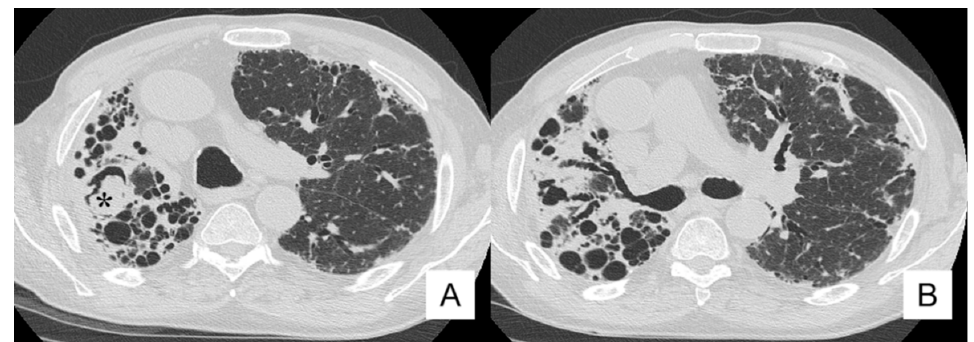
Figure 14. Same patient as the previous figure (Figure 12)—follow-up HRCT performed one year later. Images demonstrate disease progression, with an increased representation of honeycomb and traction bronchiectasis (A, B). These findings were associated with the development of cystic cavities, namely in the right upper lobe (black arrowhead in A).